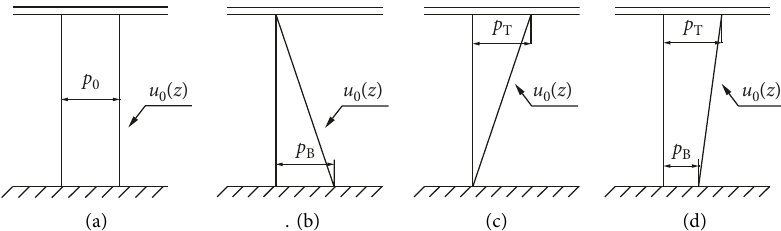
Figure 2: Nonuniform distribution of initial excess pore water pressure along depth. (a) Rectangular. (b) Positive triangle. (c) Inverted triangle. (d) Trapezoidal.